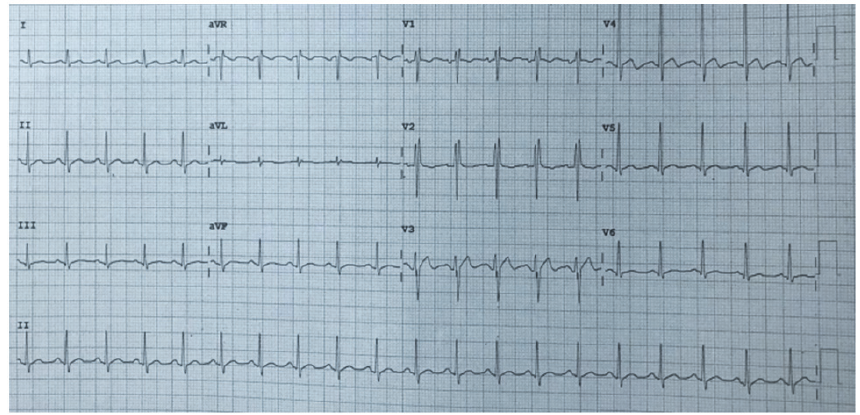
Figure 1: Patient ECG upon presentation to the